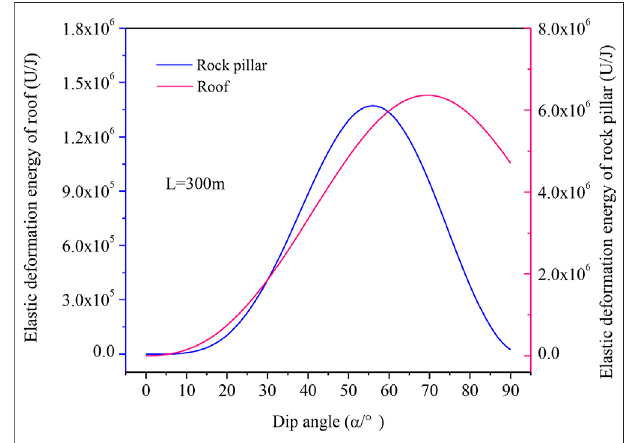
FIGURE 8 | Variation curve of the elastic deformation energy of a suspended roof and rock pillar under different dip angles (L (cid:2) 300 m).